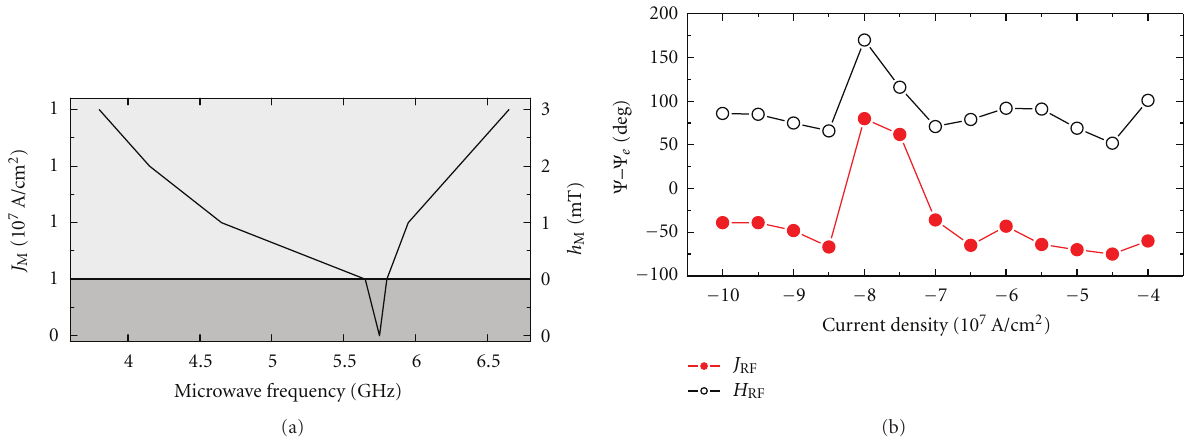
Figure 3: (a) Arnold tongue computed for H DC = 250 mT and J = − 5 × 10 7 A/cm 2 varying the magnitude of RF current and field. (b) Phase di ff erence between external force (current or field) and output magnetization as a function of dc current when an RF source at the same frequency of the free precessional one is applied. Filled-red circle: RF current, white circle: RF field.